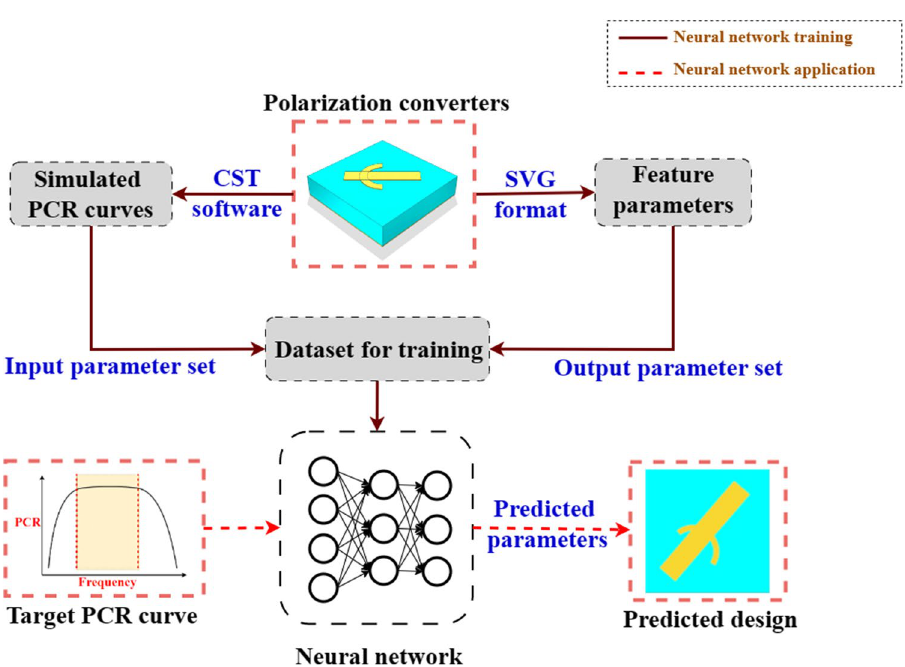
Figure 3. Block diagram illustrating the system of the proposed deep neural network training method based on vectorgraphs for designing metamaterial broadband polarization